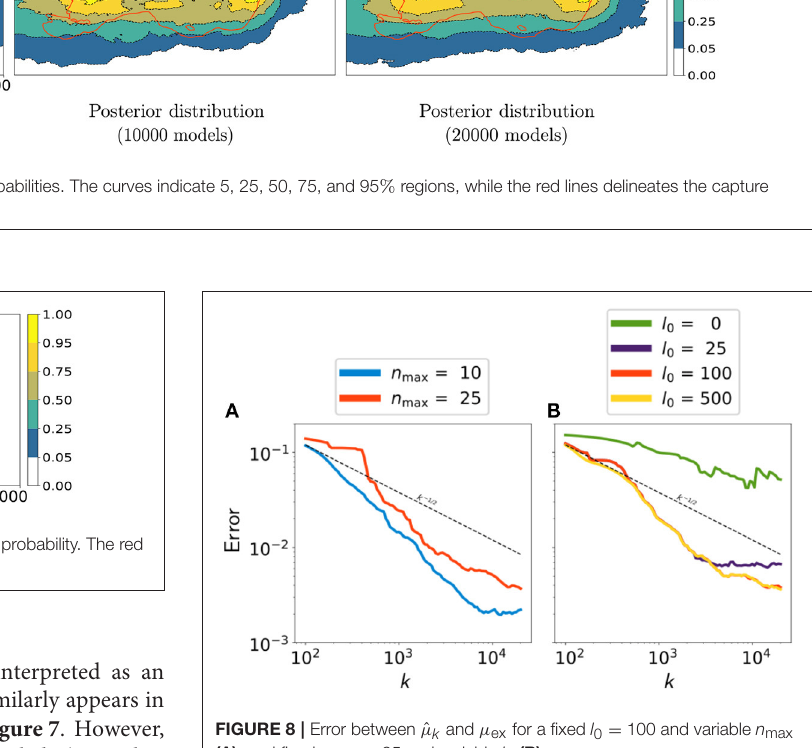
at the corresponding location belongs to the 10 days capture zone or not. A convenient distance between two Bernoulli